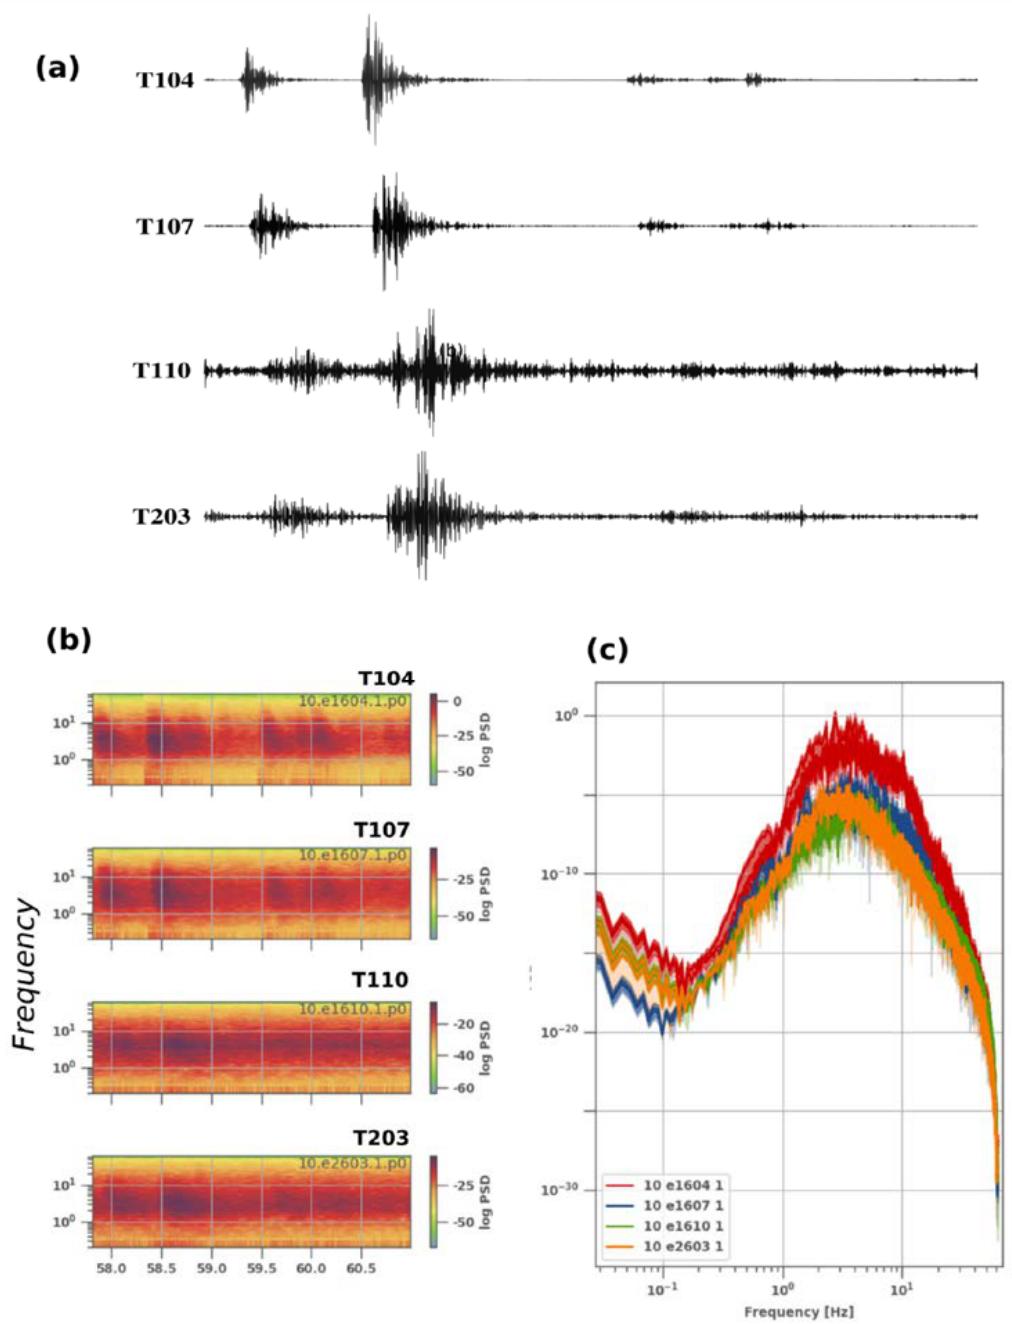
Fig. 5: (a) Example recording of two swarm events in the four sensors. The T110 and T203 stations show noise artifacts that can be associated with the subsurface condition. (b) The spectrogram from four stations also shows T110 and T203 with saturated PSD that can be related to the sediment subsurface. (c) The Fourier transform graph from all recordings highlights that T104 and T107 have higher amplitude factors than T110 and T203 (c).